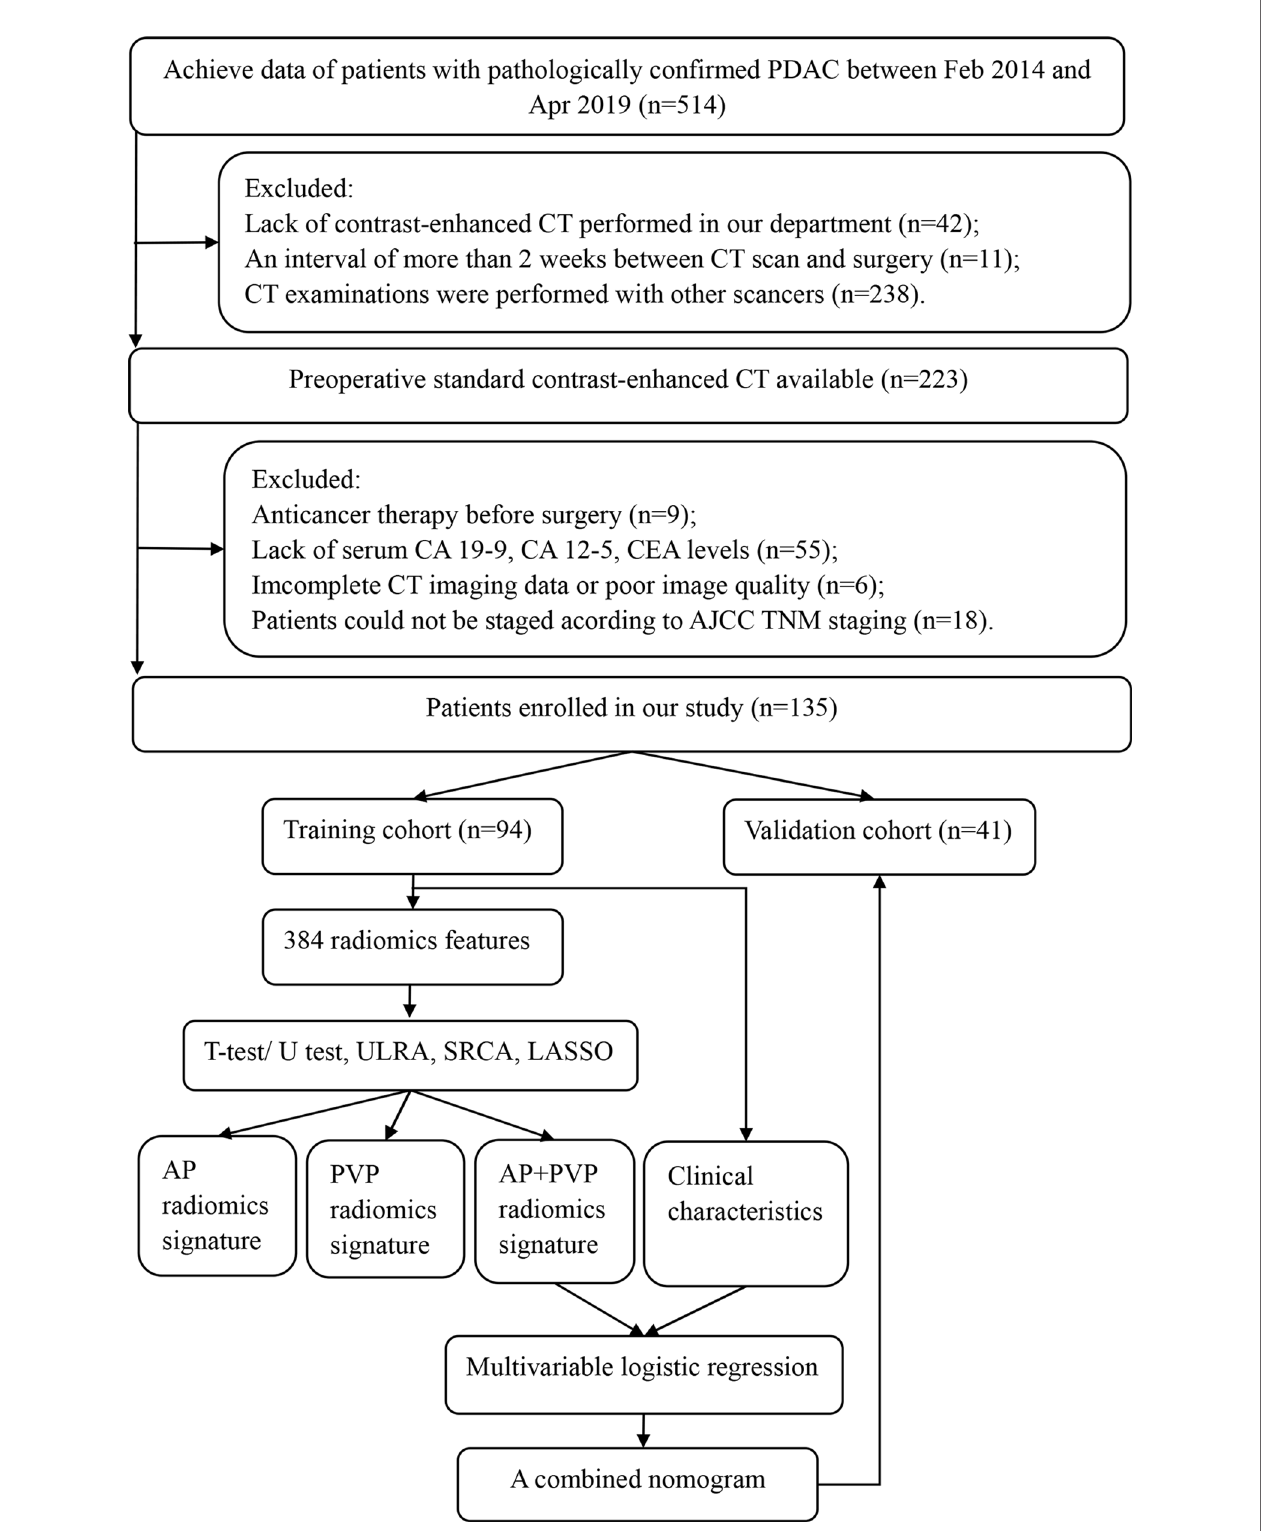
FIGURE 1 | Framework of this study. ULRA, univariate logistic regression analysis; SRCA, Spearman rank correlation analysis; LASSO, least absolute shrinkage and selection operator; AP, arterial phase; PVP, portal vein phase.